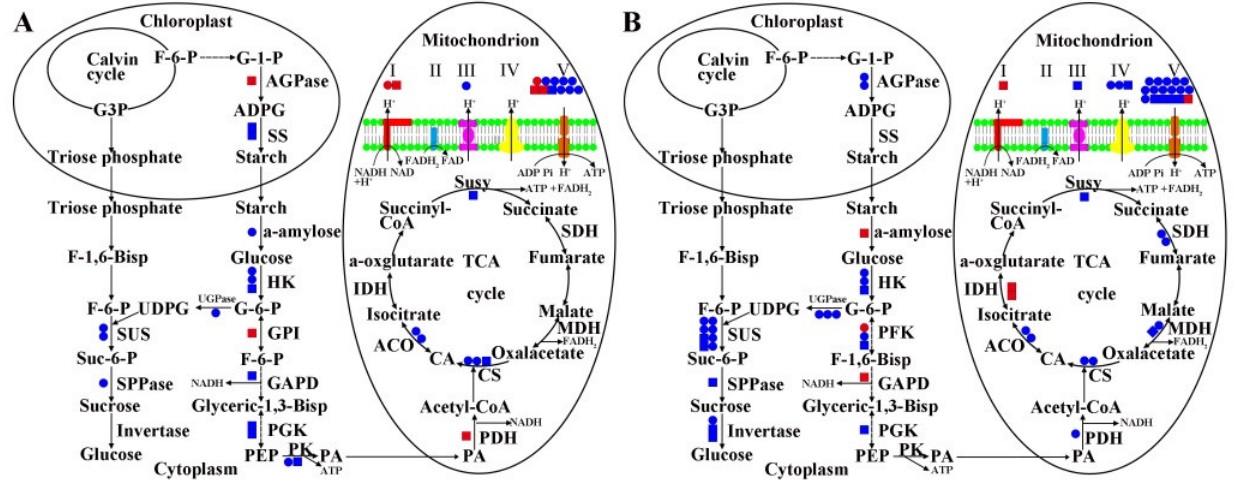
Figure 5. Integrated pathway of starch and sucrose metabolic process, glycolysis, TCA cycle, and respiratory chain pathway based on DEGs and DAPs identified in flower buds of B. juncea . ( A ) DEGs and DAPs involved in the integrated pathway in 09-05A/B lines at the TE stage. ( B ) DEGs and DAPs involved in the integrated pathway in 09-05A/B lines at the BI stage. DEGs and DAPs involved in these pathways in 09-05A were compared with those in 09-05B at the TE and BI stages, respectively. Red circle, blue circle, red square, and blue square indi- cate upregulated gene, downregulated gene, increased protein, and decreased protein, respec-